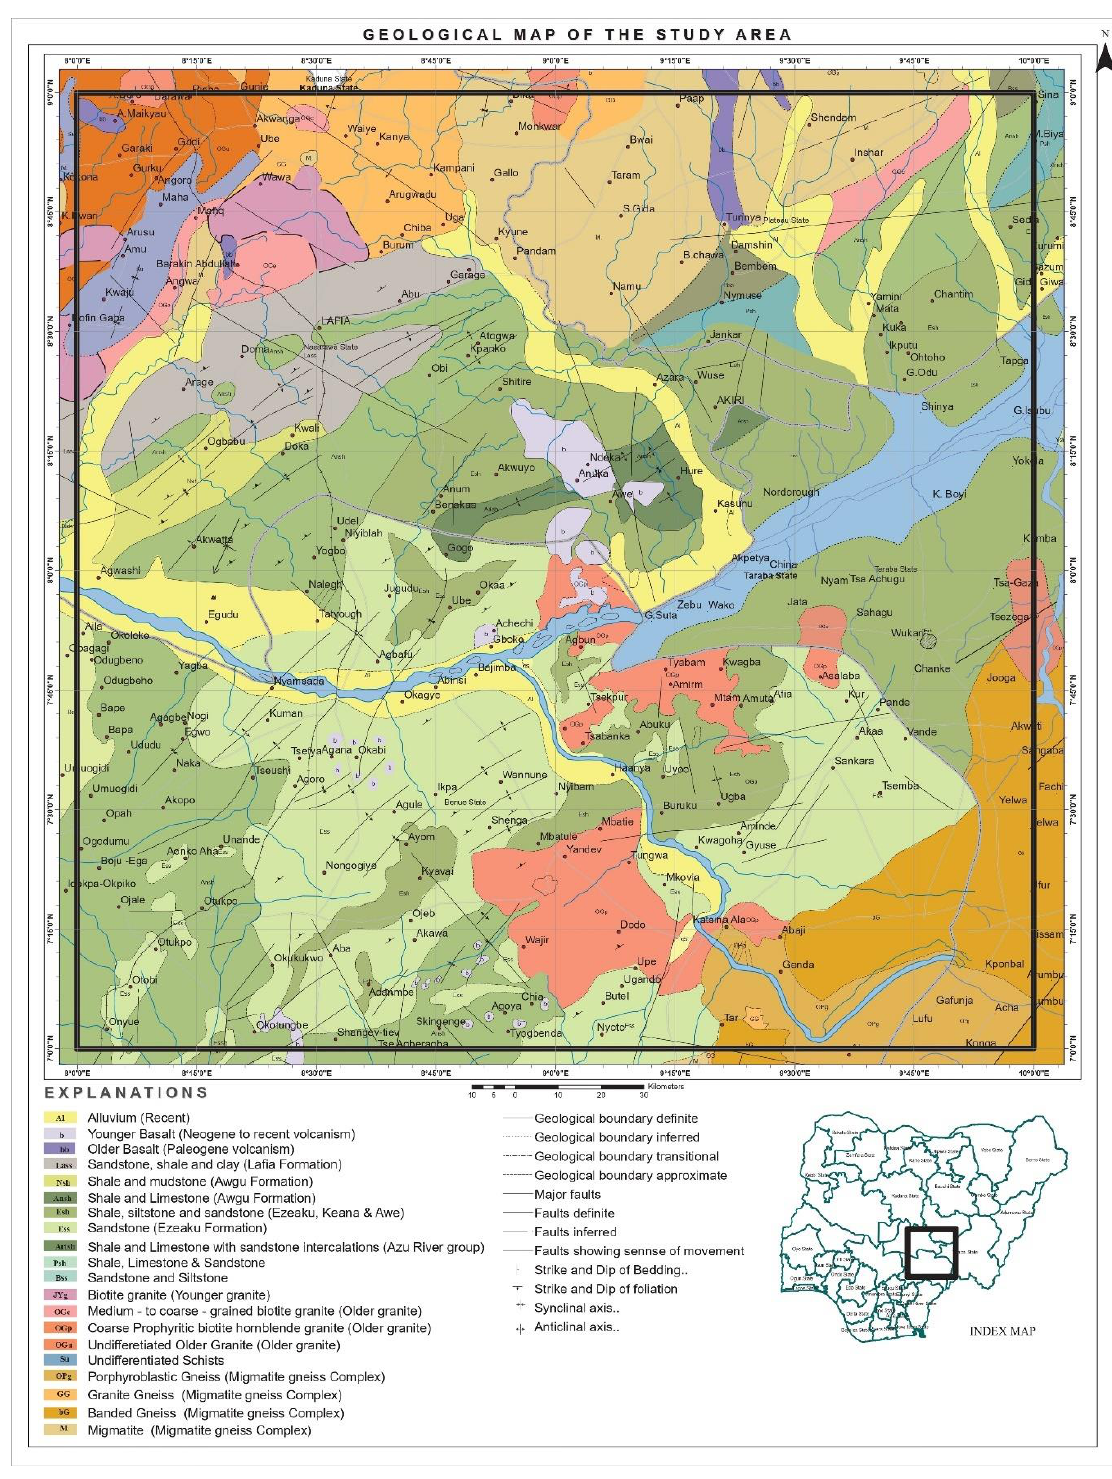
Figure 2. Geological map of the study area (modified after Nigeria Geological Survey Agency [33]). Inset is an index map showing the study area’s location within Nigeria’s landmass.